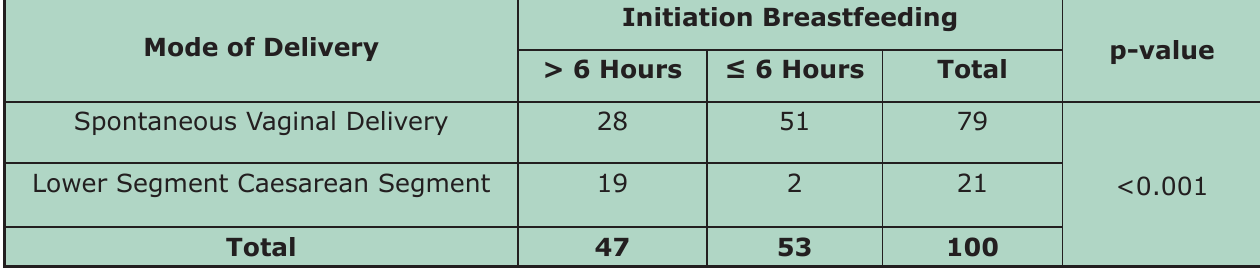
Table-II: Association between Mode of Delivery and Initiation of